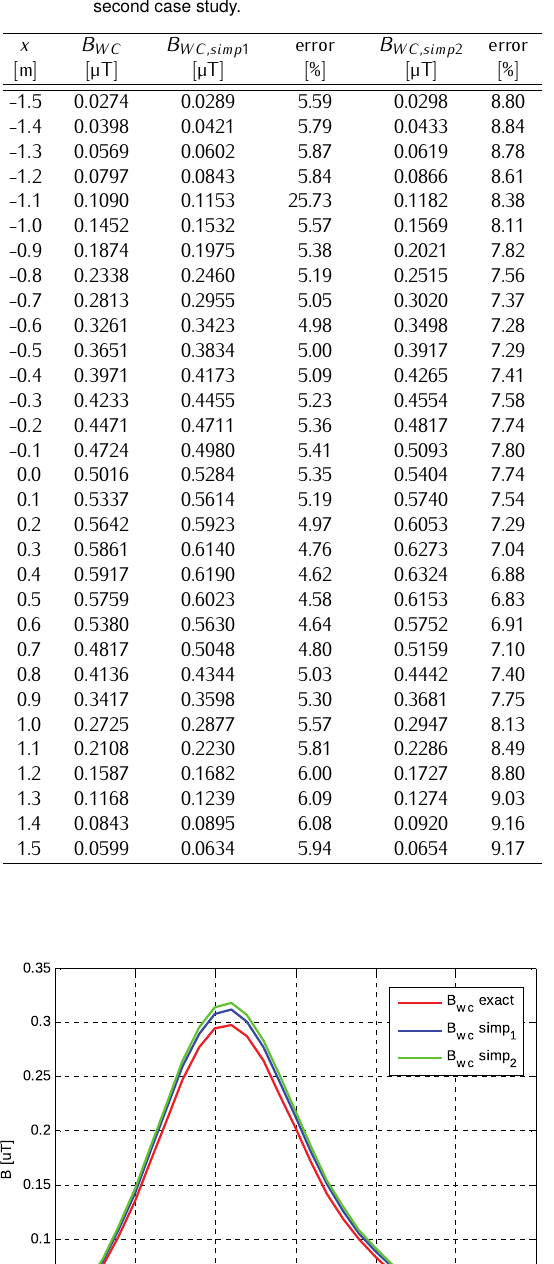
Table 6. B WC , B WC,simp 1 , B WC,simp 2 vs. distance x from the cable axis and relevant percent errors with respect to B WC for